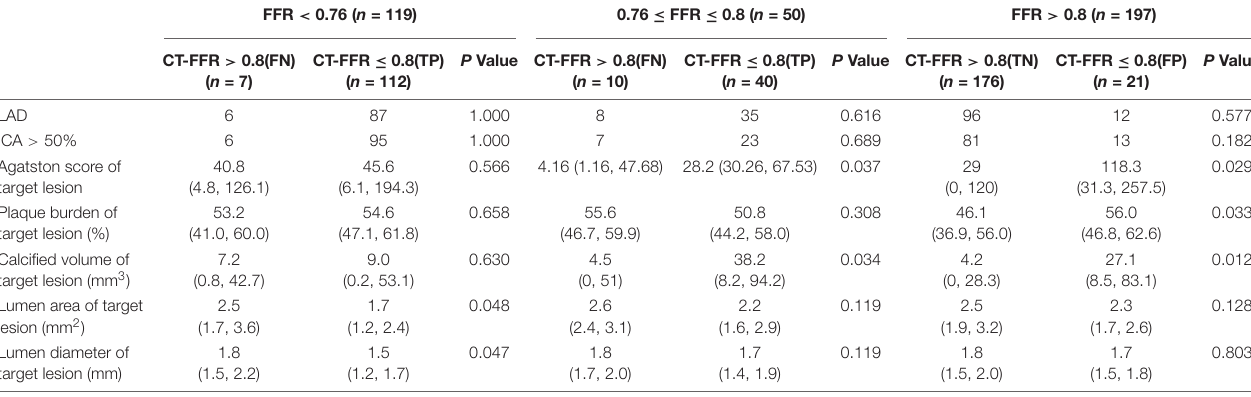
TABLE 5 | Computed tomography angiography characteristics on FP and FN lesions by CT-FFR in different FFR level. FFR < 0.76 ( n = 119)